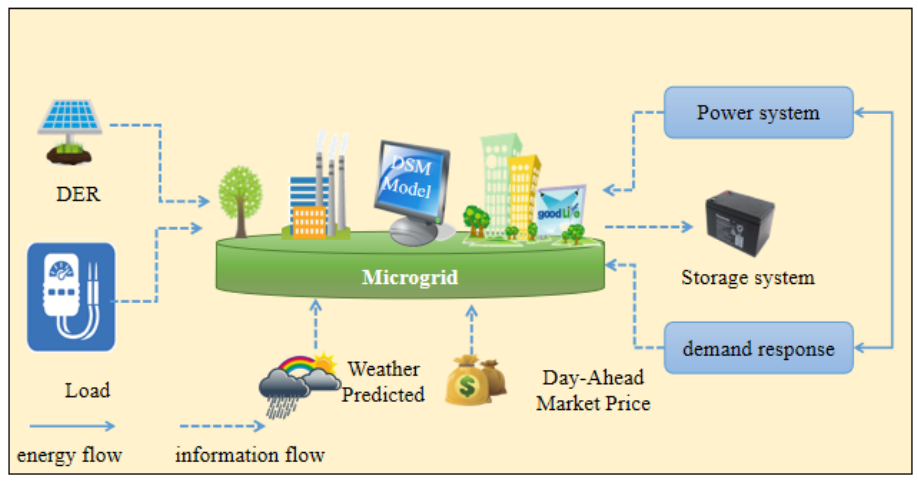
Figure 3. TES microgrid energy management system [70].